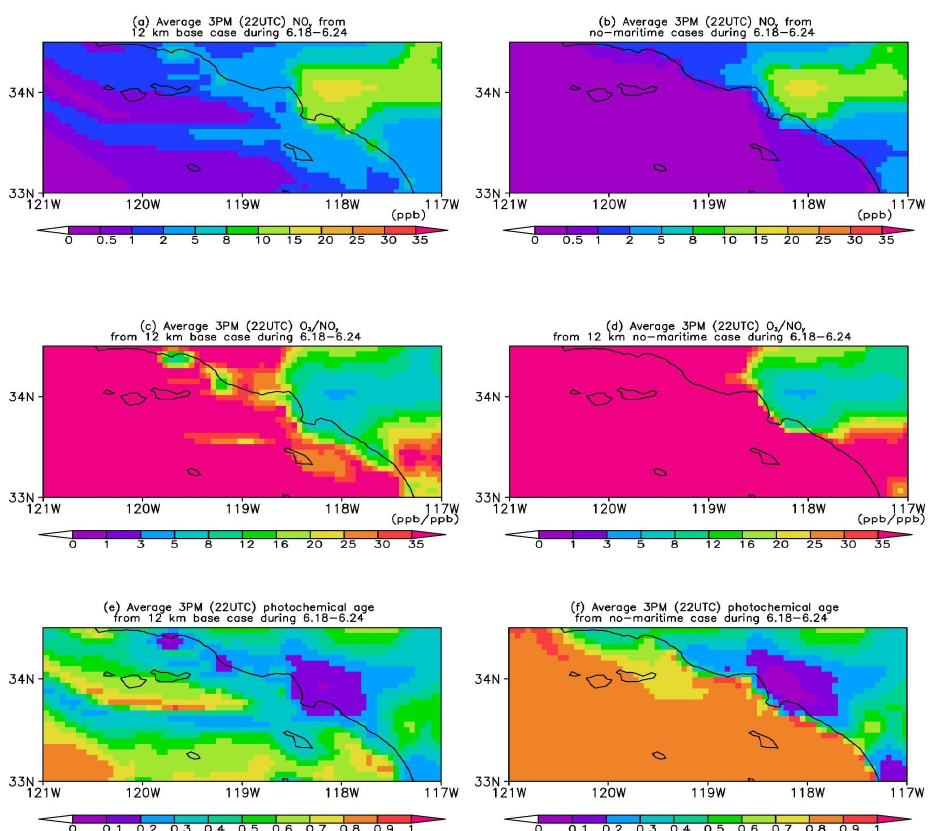
Figure 13 (a) Average 22 UTC (3pm local time) surface NO from (a) 12 km base case and (b) 12 km no-maritime case; y Fig. 13. (a) Average 22:00UTC (15:00 local time) surface NO y from (a) 12km base case and (b) 12km no-maritime case; (c) Average (c) Average 22 UTC (3pm local time) surface O /NO from 12 km base case and (d) 12 km no-maritime case; 3 y 22:00UTC (15:00 local time) surface O 3 /NO y from 12km base case and (d) 12km no-maritime case; (e) Average 22:00UTC (15:00 local (e) Average 22 UTC (3pm local time) surface photochemical age (NO /NO ) from 12 km base case and (f) 12 km no-maritime case. z y time) surface photochemical age(NO z /NO y ) from 12km base case and (f) 12km no-maritime